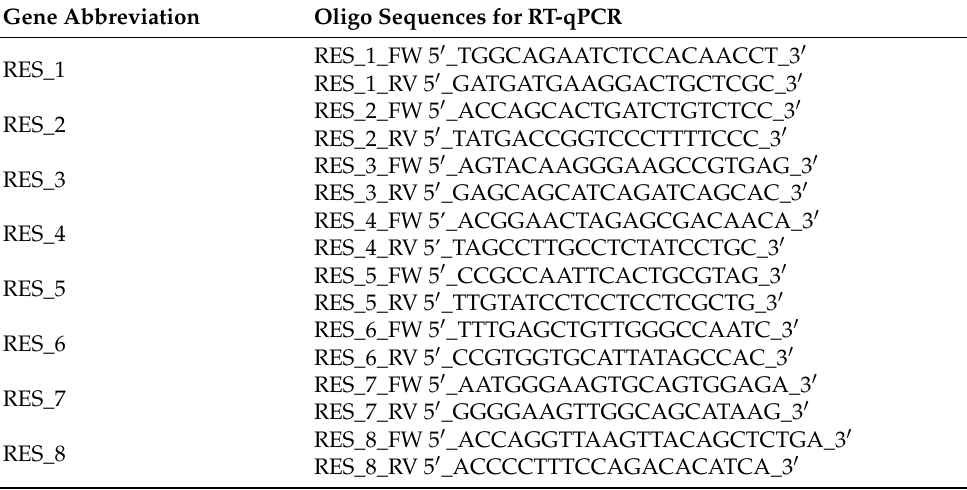
Table 1. Primers developed for RT-qPCR analysis (detailed information is reported in Table 6). Gene